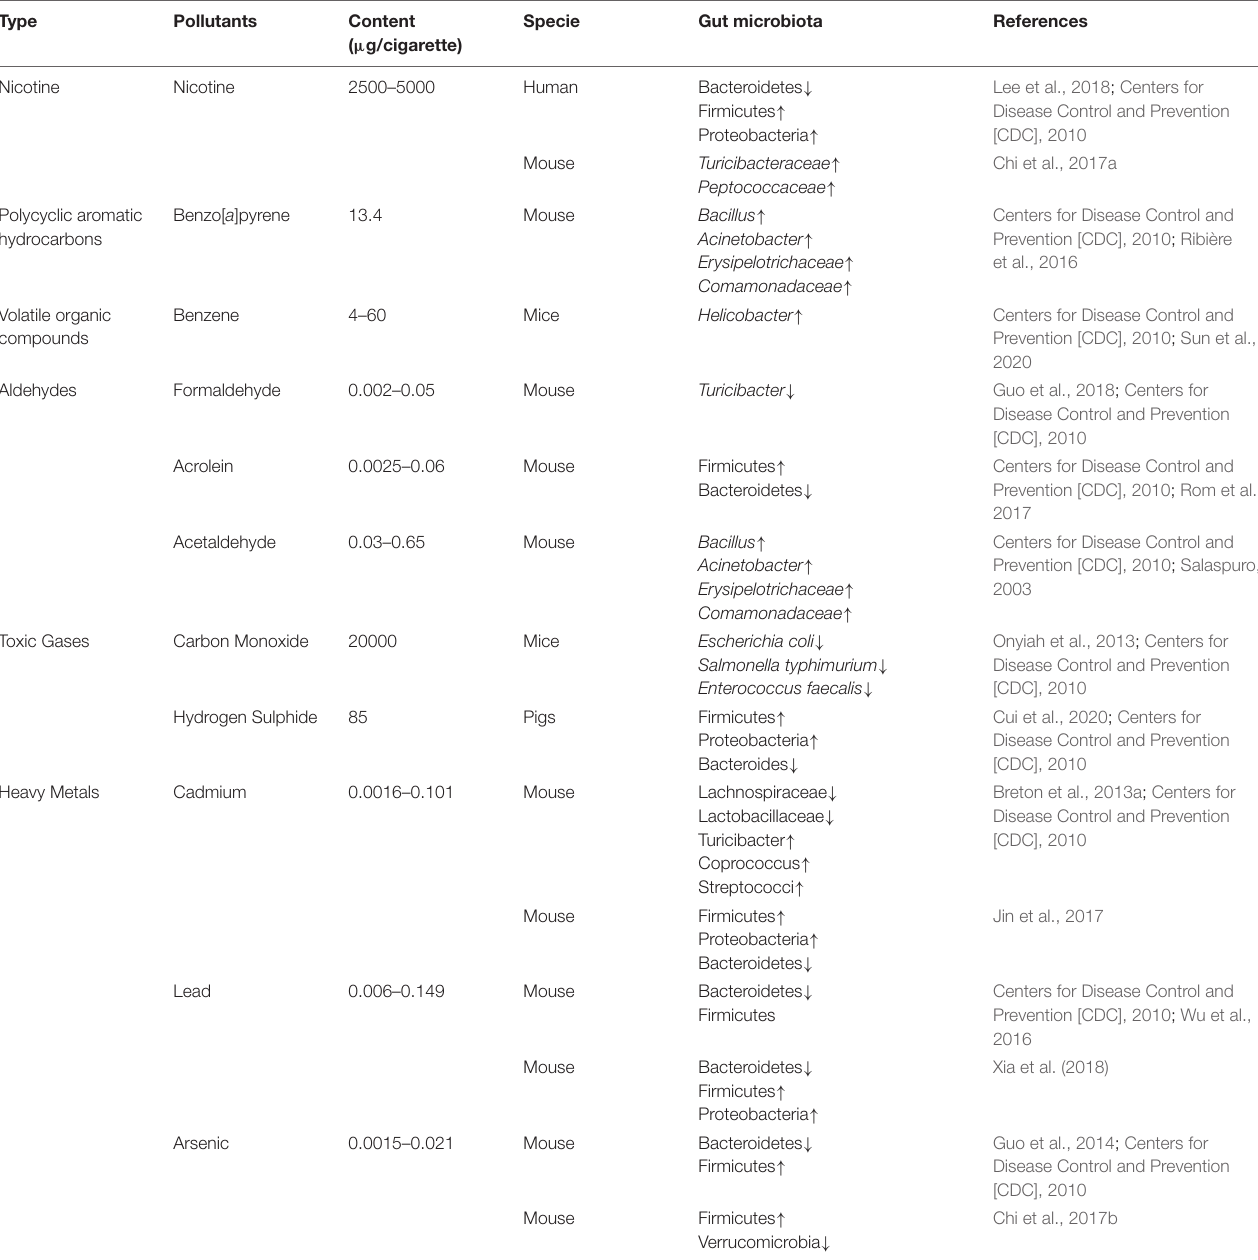
TABLE 1 | The effects of cigarette smoke toxicants on intestinal